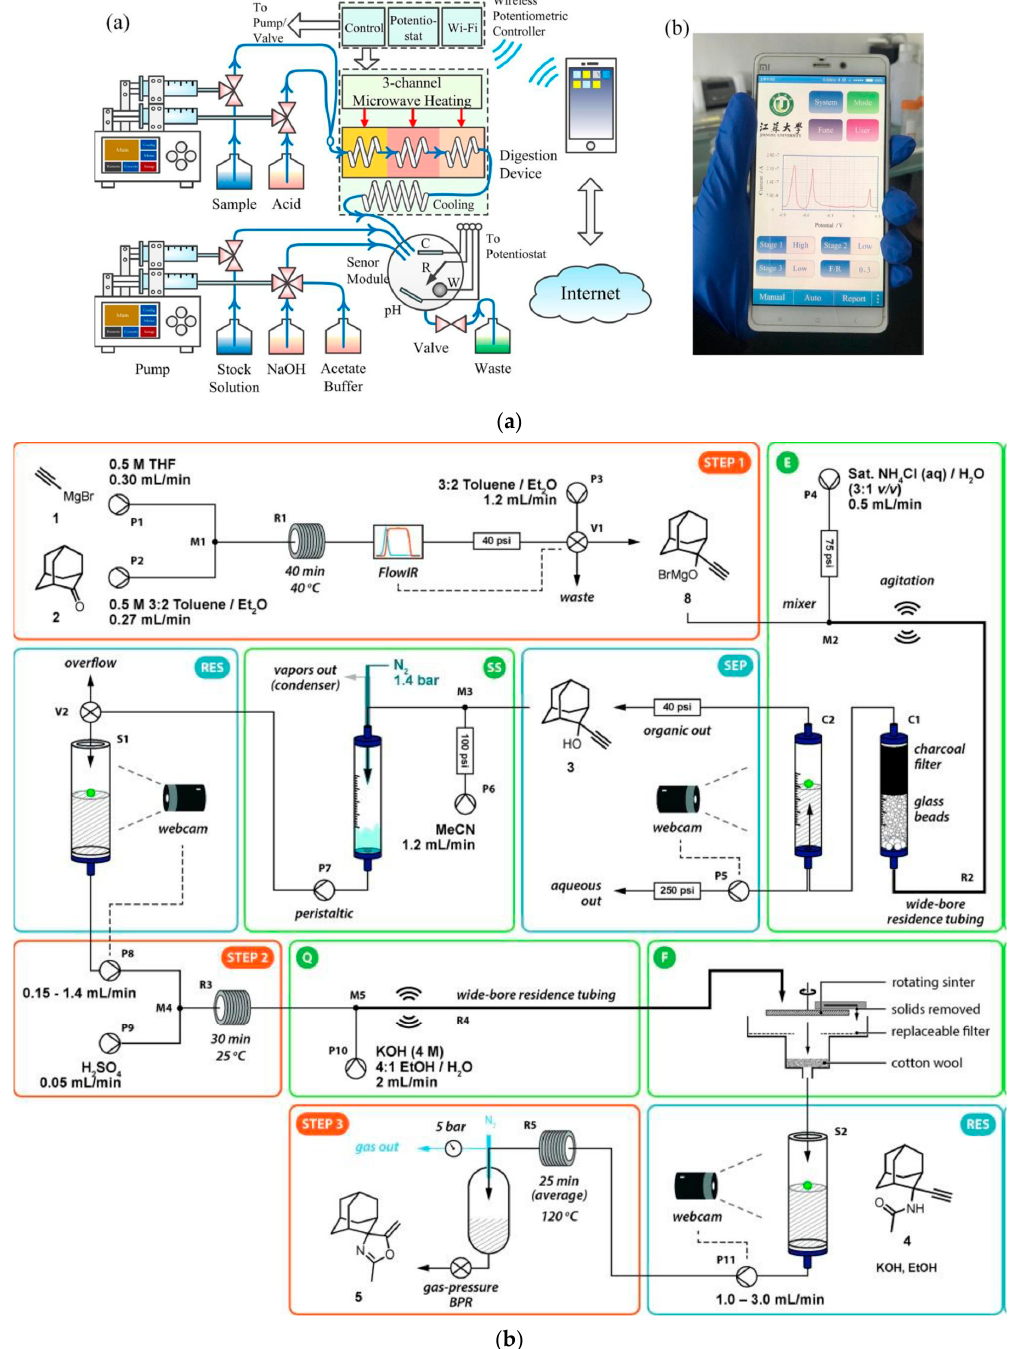
Figure 8. Examples of applications of webcam cameras in flow systems for analytical ( a ) [339] and synthetic ( b ) [340] applications: ( a ) manifold of measuring flow system involving programmable solid-state microwave flow digestion (a) and typical user interface (b) of the smart-phone-based electrochemical platform developed for determination of heavy metals in liquid foods; ( b )